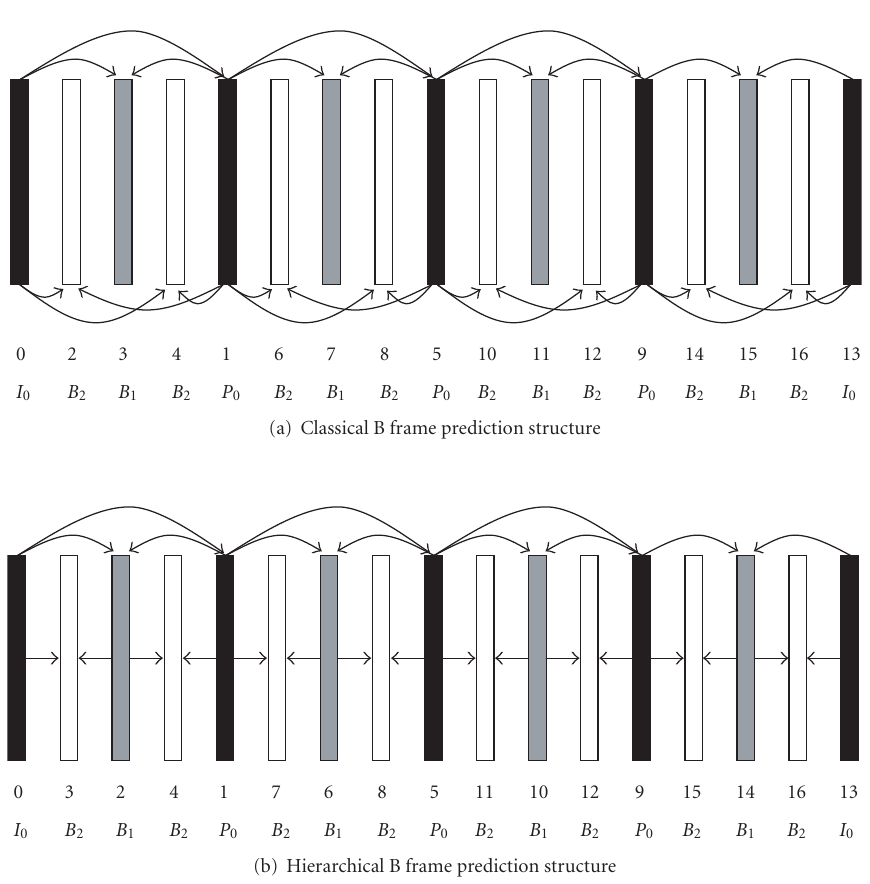
Figure 1: B frame prediction